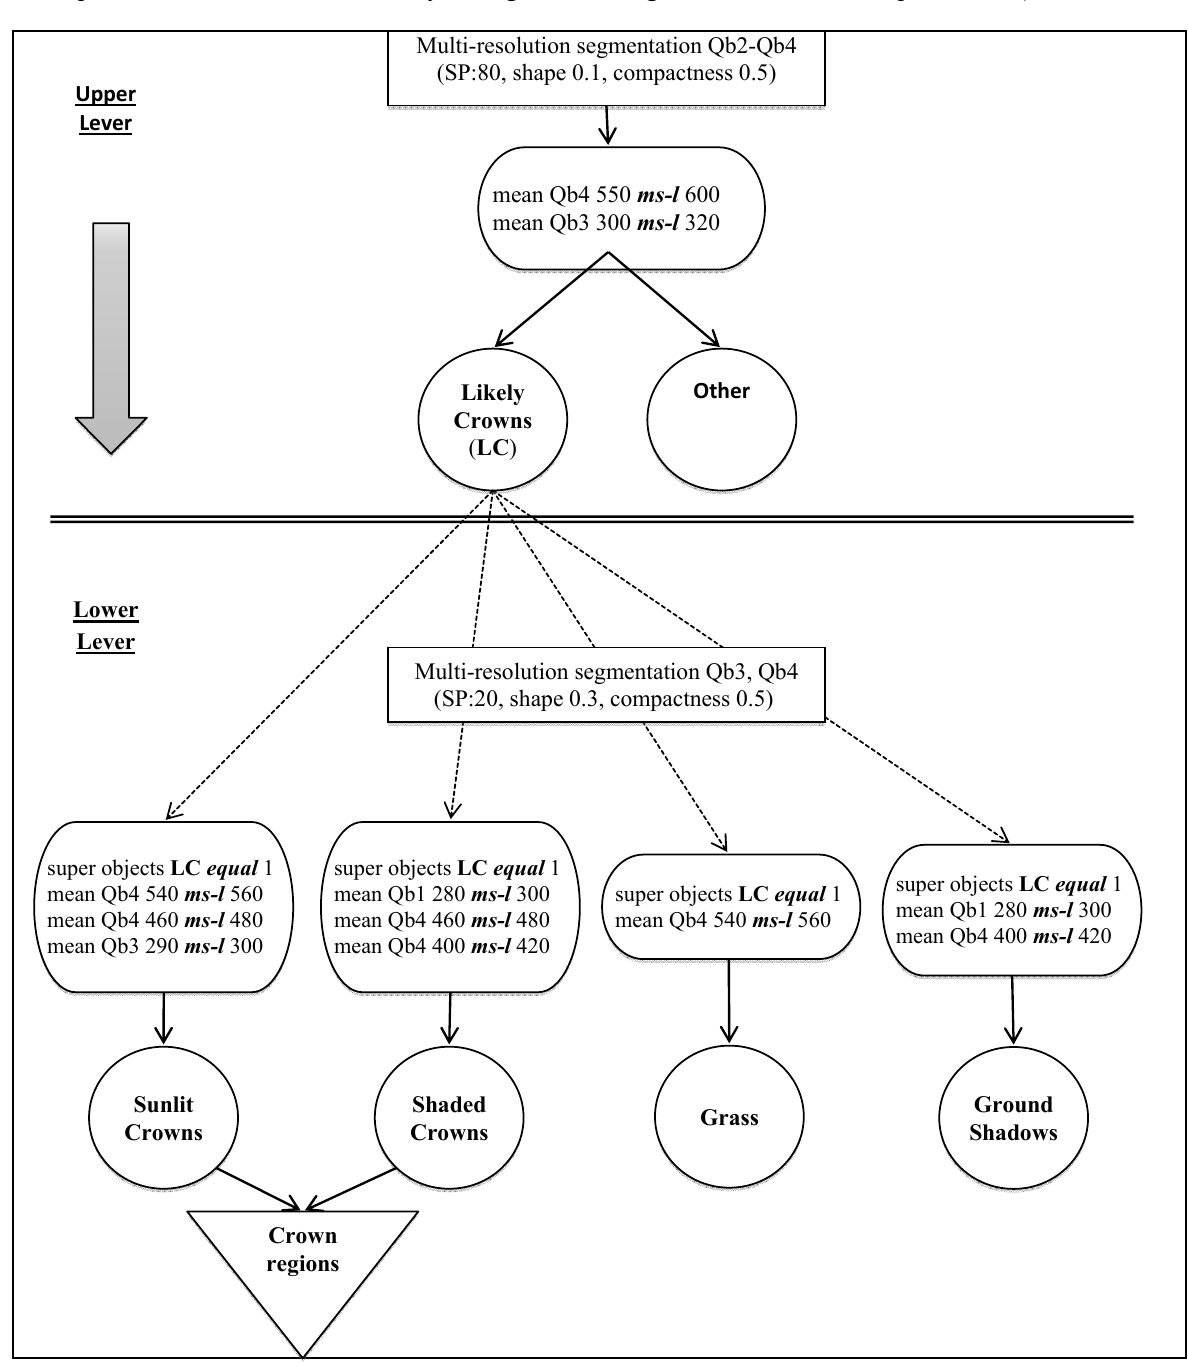
Figure 3. GEographic Object-Based Image Analysis (GEOBIA) flowchart for the Thessaloniki site. (rectangle = segmentation; oval = rule; circle = class; triangle = merge process; dashed line = hierarchy linkage; ms-l = sigmoid-left membership